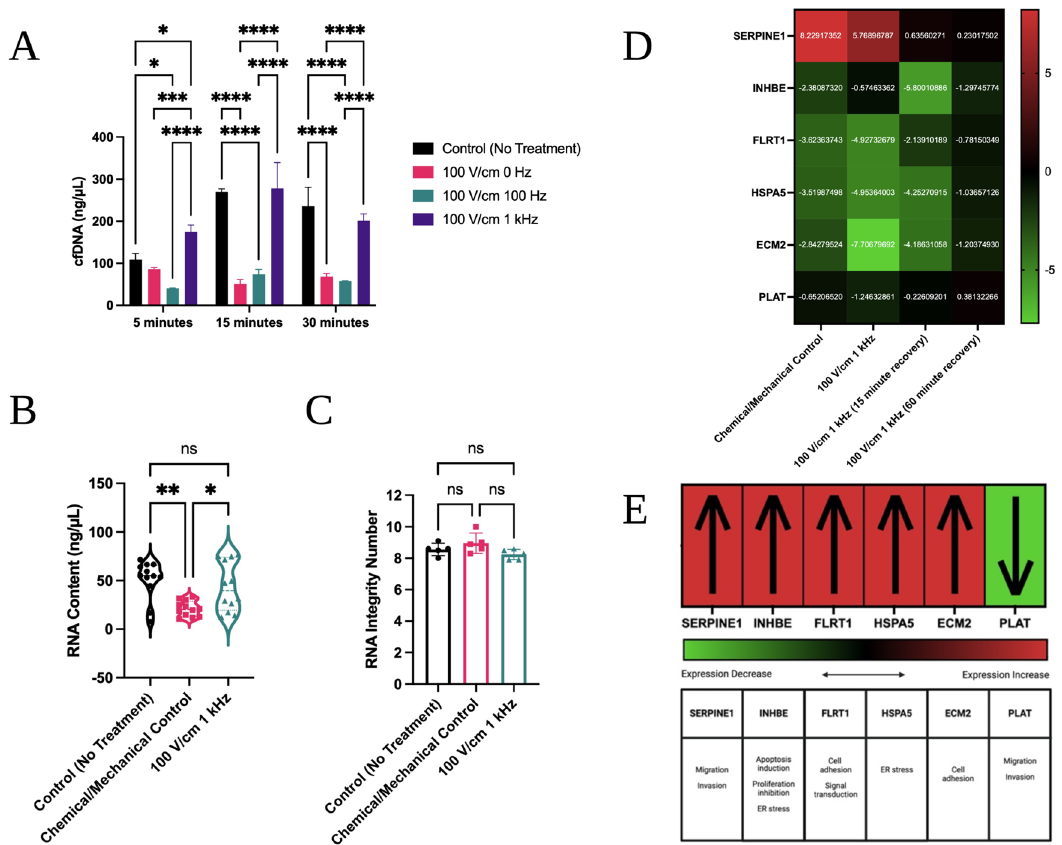
Figure 8. cfDNA in solution; extracted RNA quantity, characteristics and expression changes. ( A ) cfDNA in solution in ng/µL from whole tissue section after 5, 15, and 30 min of treatment with 100 V/cm at 0 Hz, 100 Hz and 1 kHz, or no treatment. Two-way ANOVA with Tukey post-hoc analysis and a 95% confidence interval was performed. ( B ) RNA content in ng/µL after RNA extraction from a starting population of 500,000 cells exposed to no treatment, a collagenase and mechanical agitation treatment, or the 100 V/cm 1 kHz treatment. One-way ANOVA with Tukey post-hoc analysis and a 95% confidence interval was performed ( p = 0.0014). ( C ) RNA Integrity Number (RIN) for the extracted RNA samples. One-way ANOVA with Tukey post-hoc analysis and a 95% confidence interval was performed ( p = 0.0941). ( D ) RT-qPCR expression profile changes for 6 indicators across treatments. ∆Cq was calculated for each treatment group by using a control expression baseline followingestablished guidelines 32 . Differential expression was then examinedwith a heatmap analysis and compared to ( E ) stress response signatures for the MDA-MB-231 cell line. * p < 0.05, ** p < 0.01, *** p < 0.001, **** p <